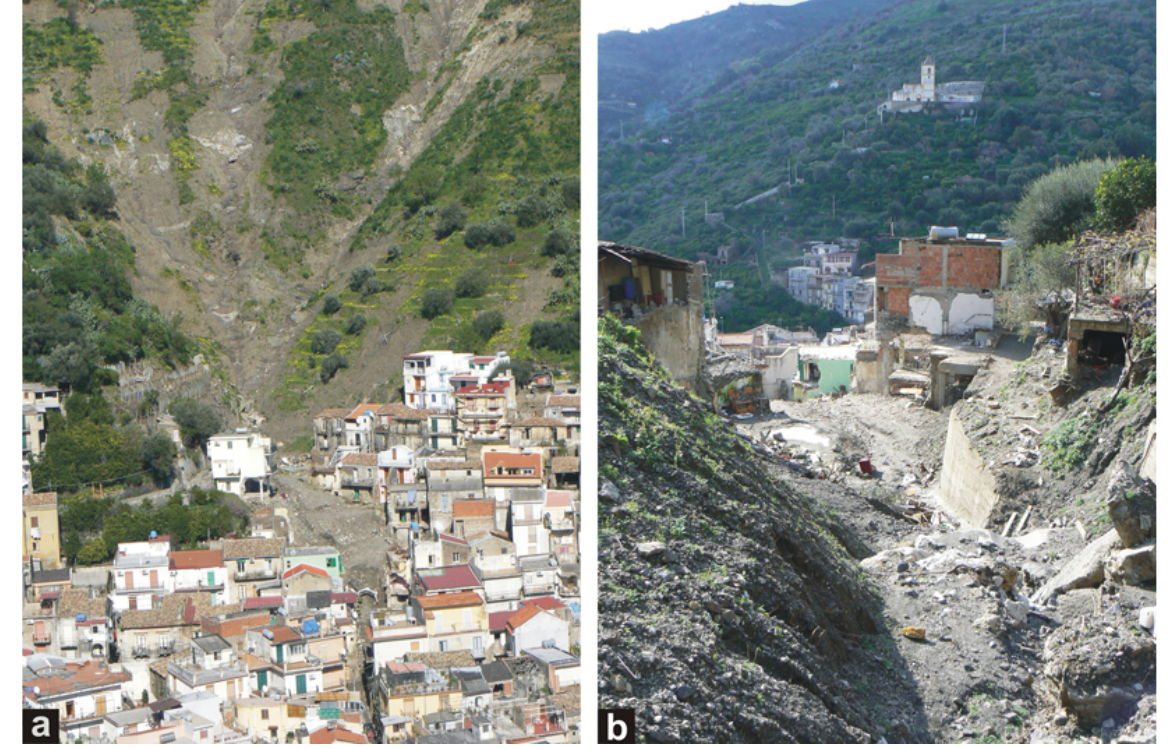
Fig. 2. Examples of some shallow landslides triggered by October 1st 2009 rainfall event in Giampilieri village: (a) front view; (b) downslope